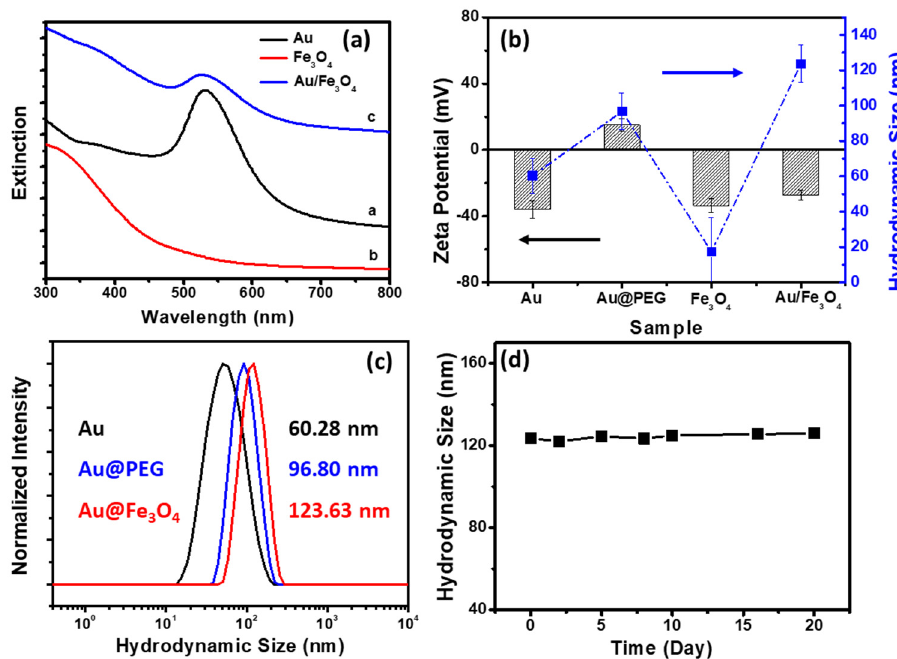
Figure 2. ( a ) UV-visible spectra of Au nanoparticles, Fe 3 O 4 nanoparticles and Au-Fe 3 O 4 nanocomposites. ( b ) Changes in the hydrodynamic sizes and zeta potentials of Au nanoparticles, Au nanoparticles with PEG coating, as-transferred Fe 3 O 4 nanoparticles and Au-Fe 3 O 4 nanocomposites. ( c ) Hydrodynamic sizes of Au nanoparticles, Au nanoparticles with PEG coating and Au-Fe 3 O 4 nanocomposites. ( d ) Colloidal stability test of Au-Fe 3 O 4 nanocomposites.